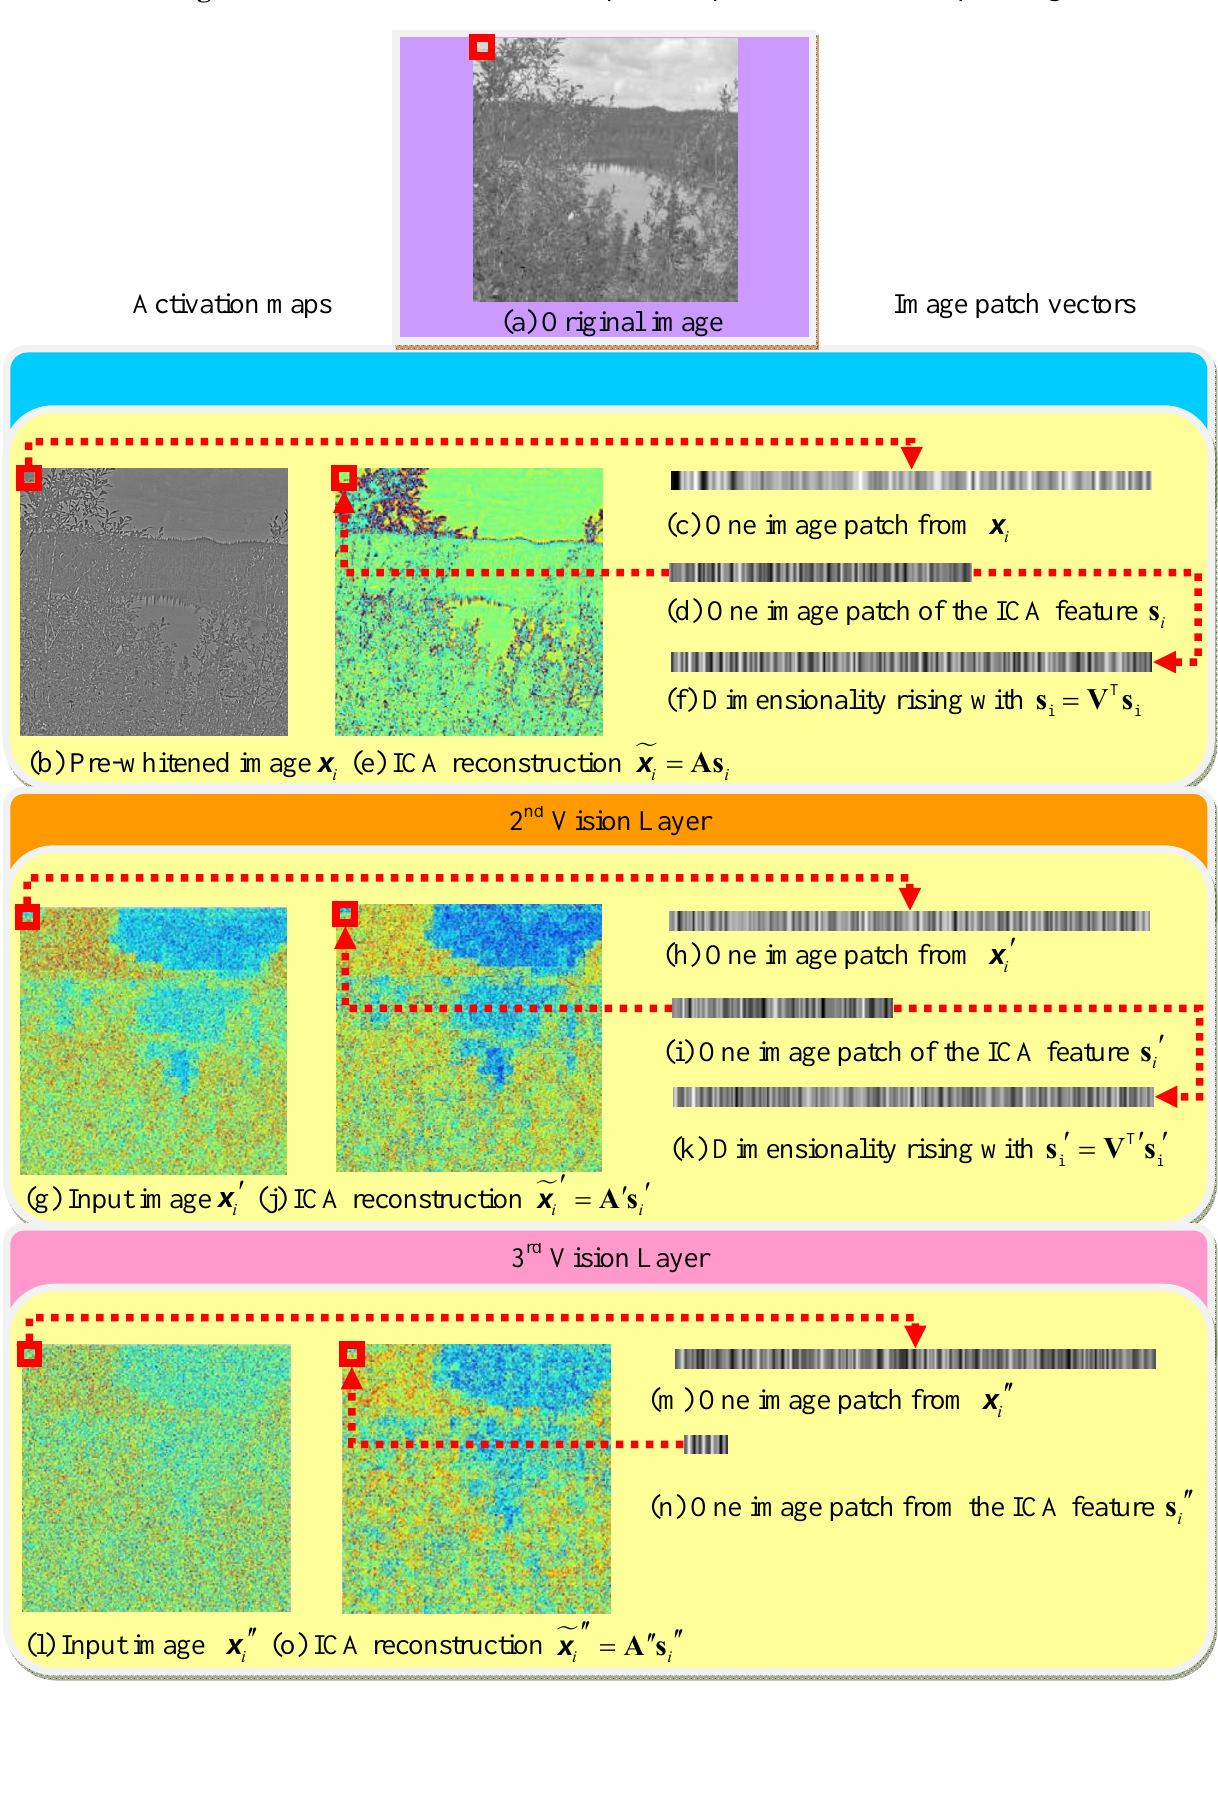
Figure 7. The hierarchical ICA computation process of one example